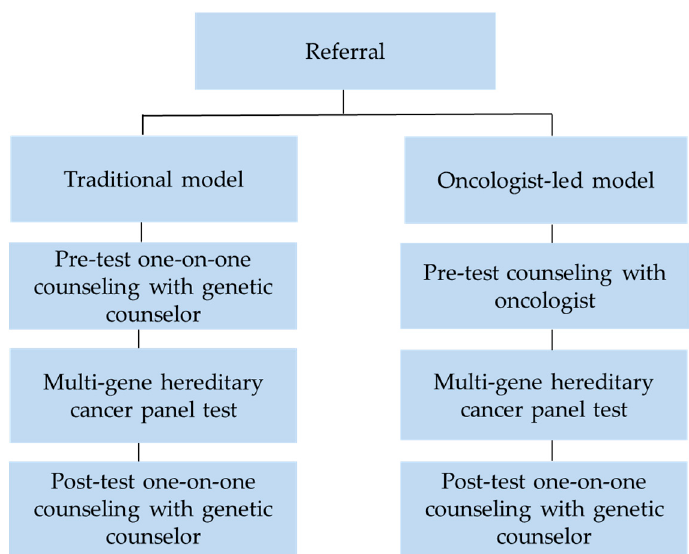
Figure 2. Clinical Models: The traditional clinical model involved pre-test and post-test one-on-one genetic counselling with a genetic counsellor. The streamlined oncology clinic-based model involved pre-test counselling by an oncologist with the initiation of genetic testing at a clinic visit. Once available, patients in both models were provided test results by a genetic counsellor.